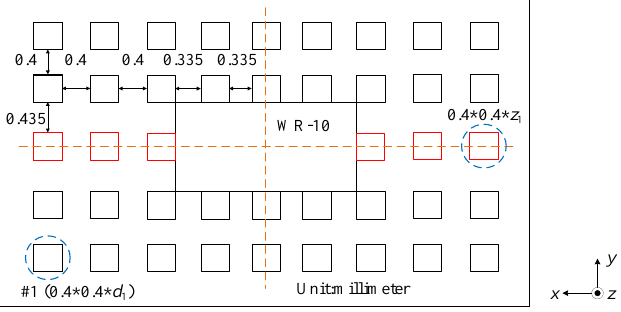
Figure 3. Configuration of the transition in the xy plane.